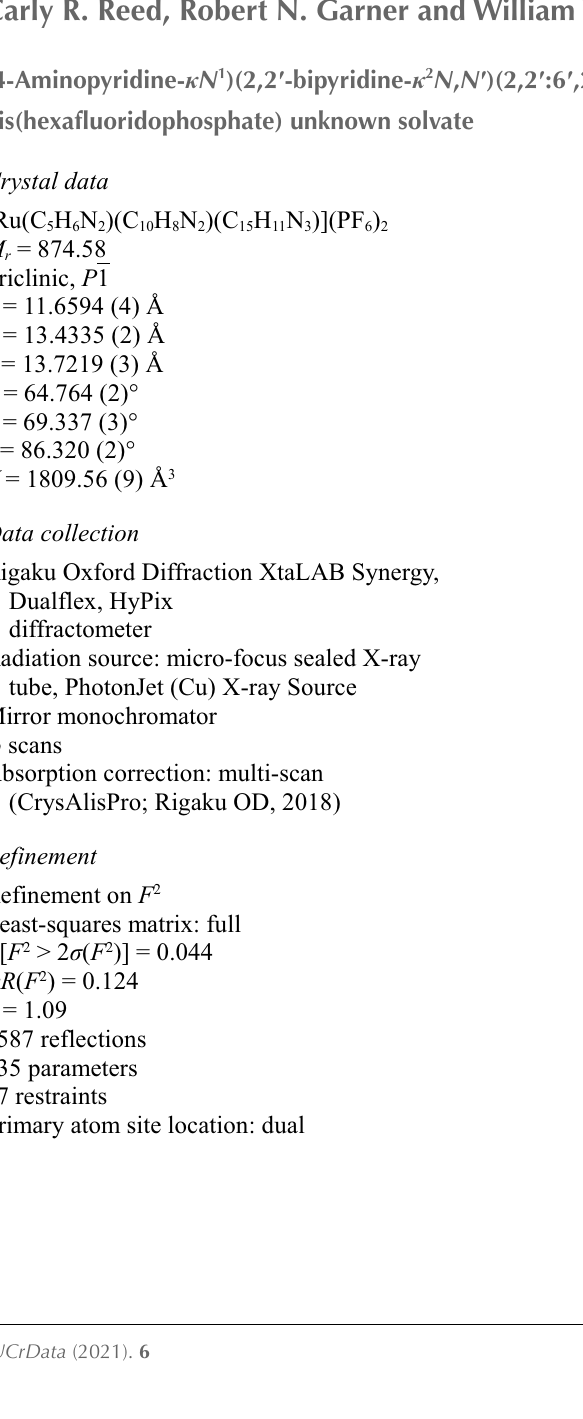
full crystallographic